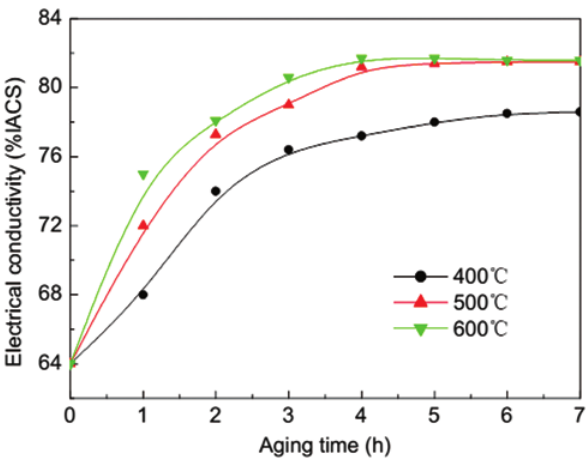
Figure 3: Curves of the electrical conductivity with aging time and aging